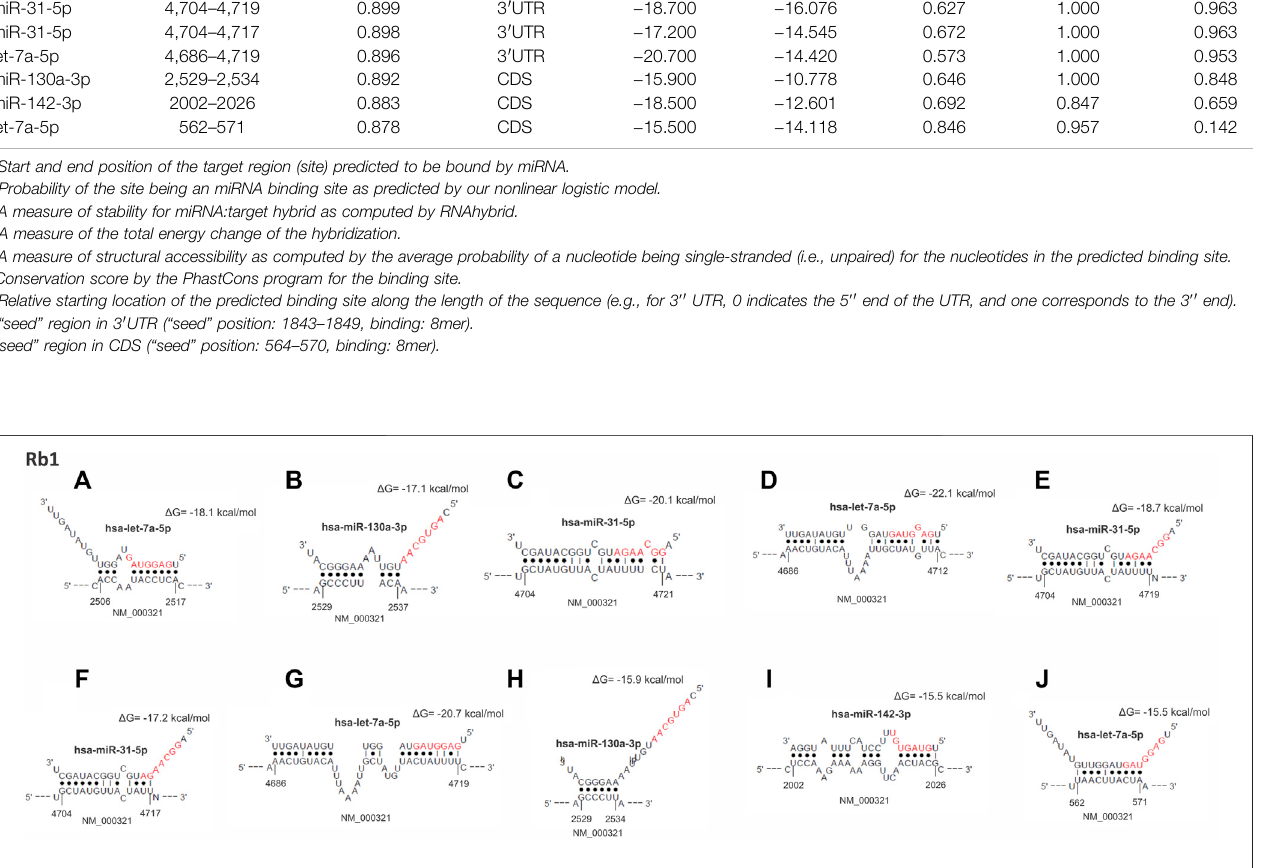
FIGURE 3 | From (A – J) , hybrid mRNA (RB1) — miRNA upregulated. The upper and lower sequences represent the miRNA in the 3 ′ -5 ′ sense and 5 ′ -3 ′ sense hybridization sites in the mRNA, respectively. The numbers at the ends of the mRNA show the starting and ending position of the hybridization sites. Dots between